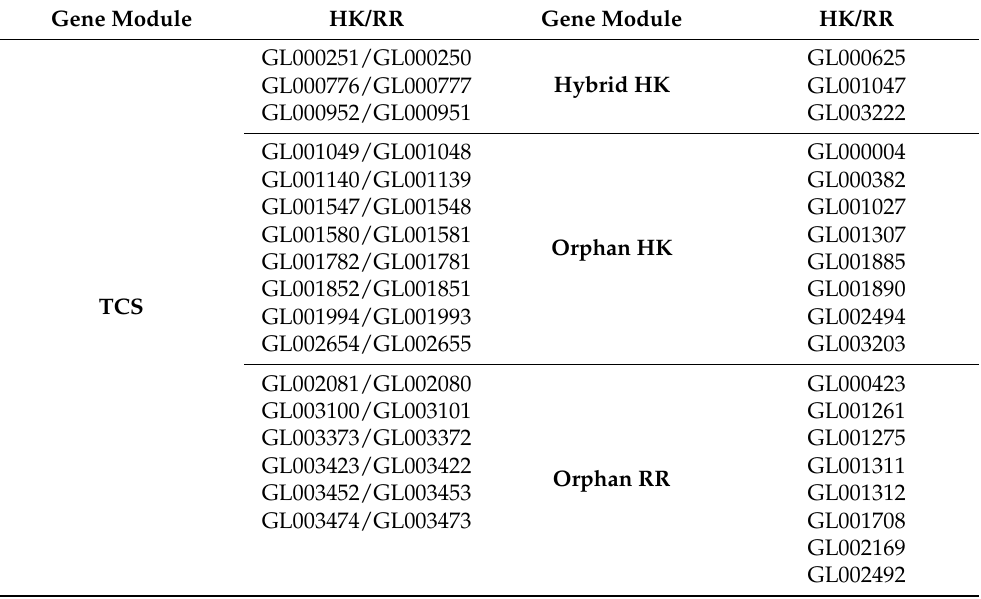
Table 2. Summary of putative TCS proteins in L. populi N-5-1. Gene